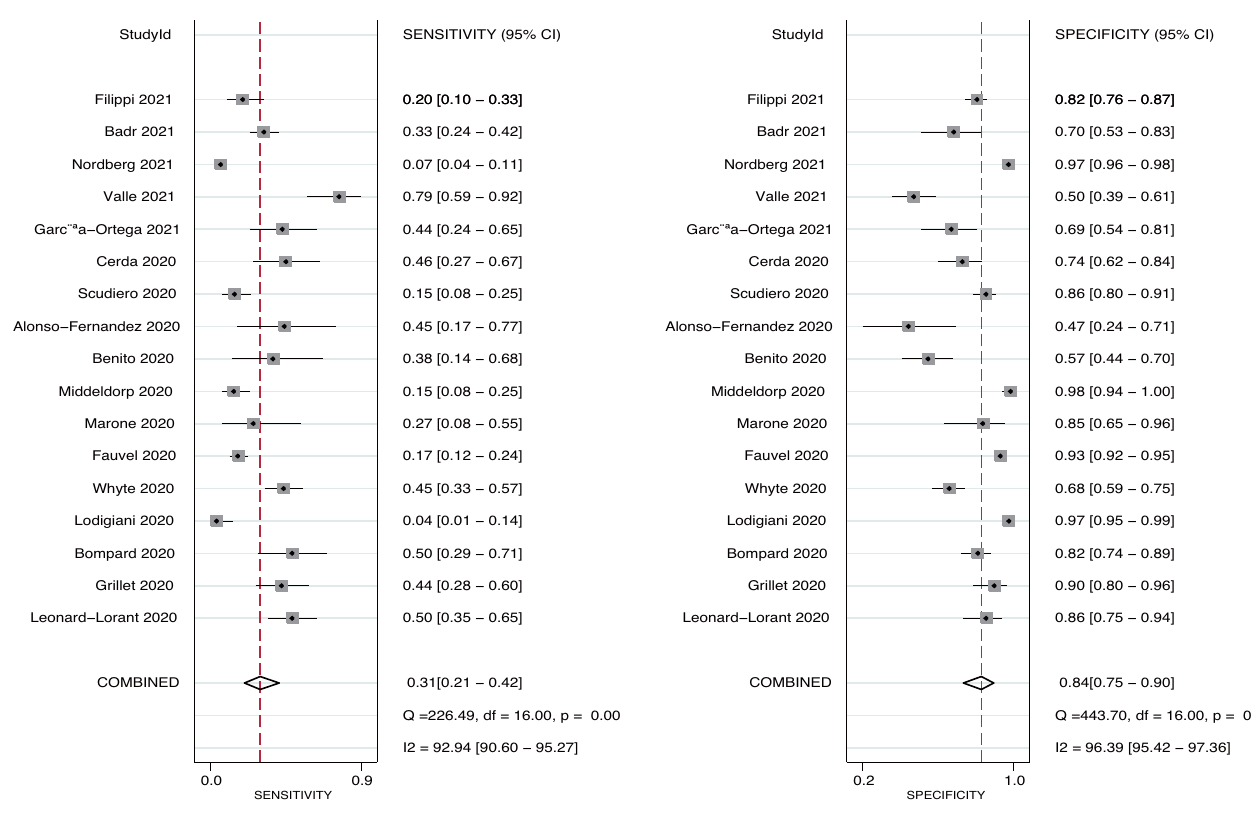
Fig 3. Pooled sensitivity and specificity for pulmonary embolism on subsequent ICU admission.